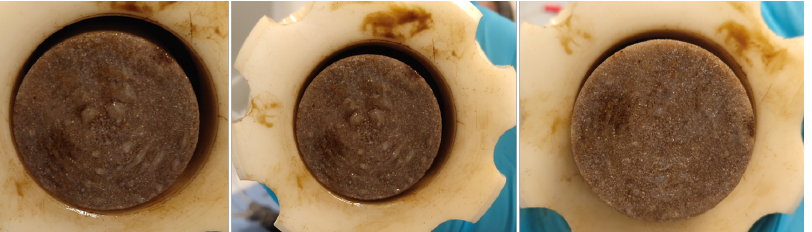
Figure 6. Physical filtration and formation of nanoparticle “cake” at core inlet during nanofluid